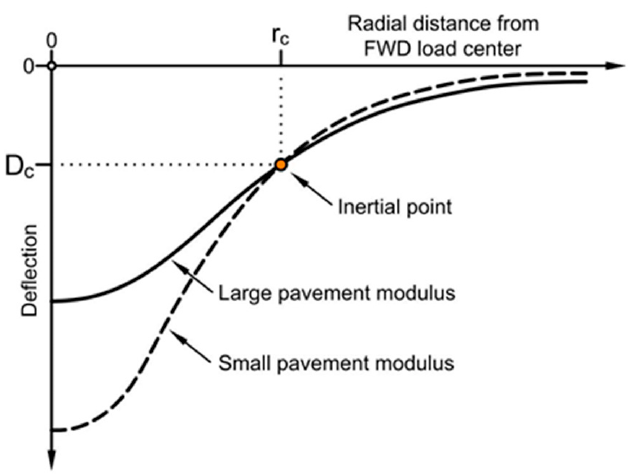
Figure 8. Diagram of the different pavement modulus intersections of the deflection bowl [21,22].